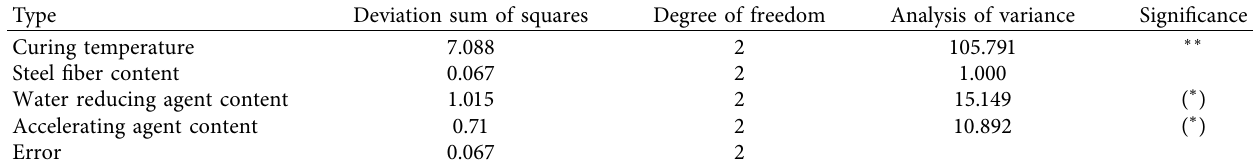
Table 8: Table of variance analysis of compressive strength of 1-day-old concrete specimen.